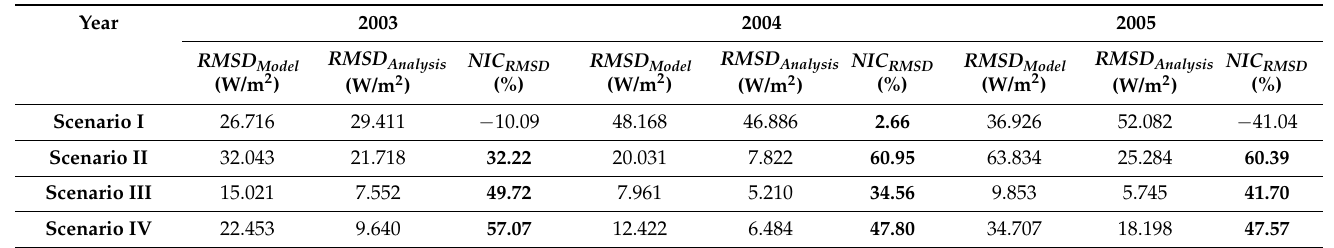
Figure 4. Sensible heat fluxes prediction from OL and MLDAS in 2003–2005. Predictions of four assimilation scenarios are given. Columns represent different assimilation scenarios in each year. The red solid line in each subplot represents MLDAS prediction in one future month; the blue dashed line in each subplot represents OL simulation; and the green hollow scatters represent H benchmarks. Table 2. NIC RMSD of sensible heat fluxes in different assimilation scenarios (I–IV) in 2003, 2004, and 2005. Positive NIC RMSD numbers are marked in